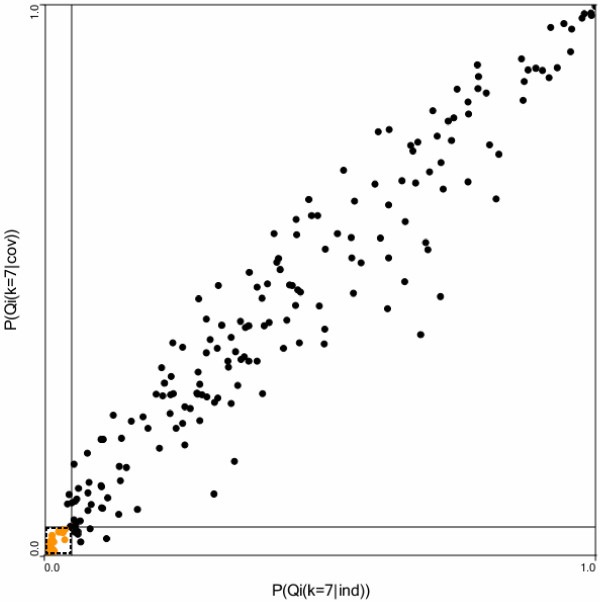
Probability of the local Q statistic at k = 7 not accounting for
smoking, age, gender, race and education (x axis) versus the
probability of the local statistic accounting for smoking and these covariates
(y axis). The 20 points in the lower left quadrant are centers of
significant case clusters even after smoking and the four covariates are
accounted for. The 6 points in the lower right quadrant were cases that have
become significant after covariate adjustment. 4 cases were significant before
covariate adjustment but not afterwards.